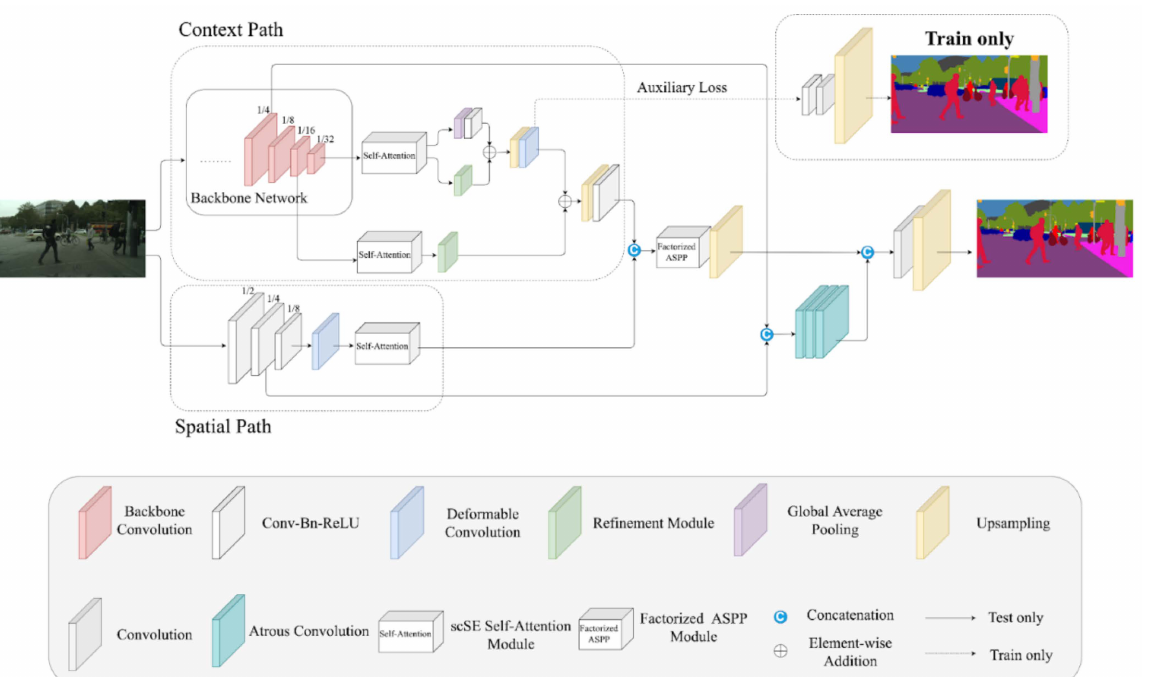
Figure 2. The proposed overall network